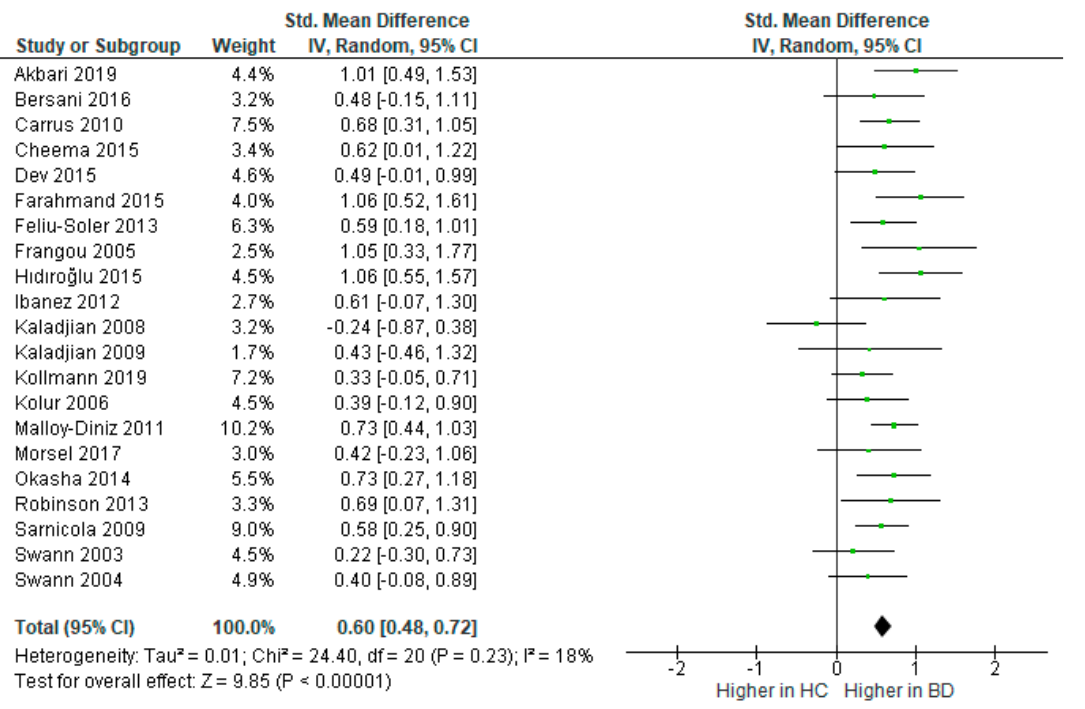
Figure 3. Forest plot of standardised mean differences (SMD) for response inhibition between bipolar disorder (BD) and healthy controls (HC).